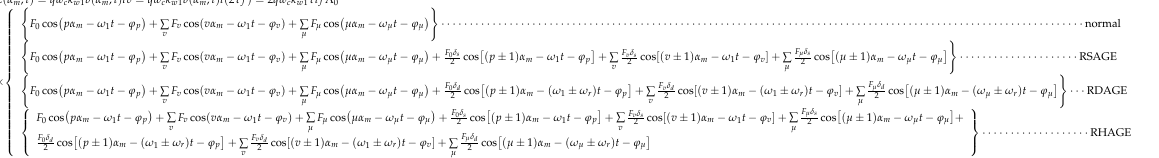
where f is the mechanical rotation frequency of the rotor. l is the air-gap length. q is the number of slots per pole per phase. τ is the pole pitch. w c is the number of turns of a single coil. k w 1 is the fundamental winding factor, the expression of which is